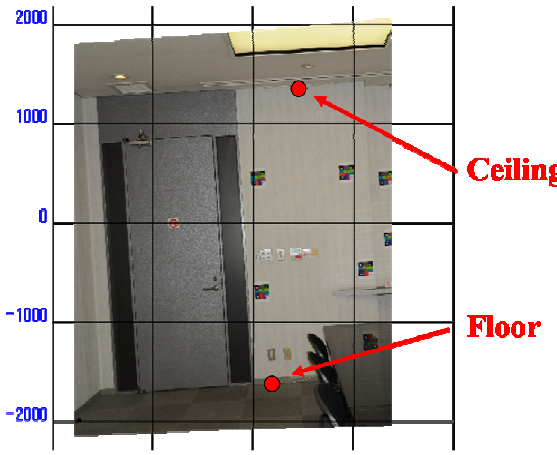
Figure 8. Determination of wall height. Points on the border lines between ceiling, floor and a wall are selected in the orthographically projected